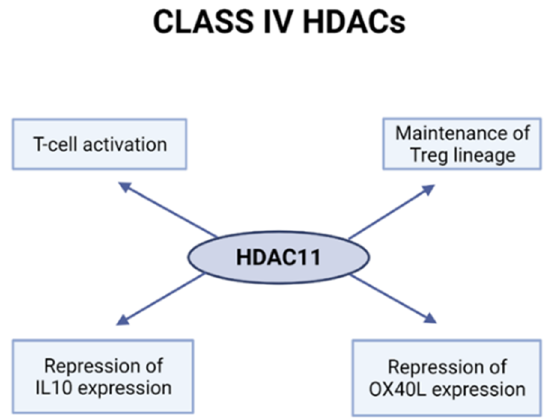
Figure 4. Role of class IV HDACs in T-cells. Created with BioRender. HDAC11 was also shown to be involved in the functioning of Treg cells through the regulation of Foxp3 [119]. Foxp3 plays a crucial role in Treg development and functions by regulating the expression of genes that determine the phenotype and suppressive ac- tivity of Tregs. Not only does HDAC11 regulate Foxp3 expression, but it can also bind to Foxp3 and promote its deacetylation. Deletion of HDAC11 in Foxp3+ Tregs enhanced Foxp3 expression and promoted the expression of other genes important to the develop- ment and maintenance of the Treg lineage and their suppressive role. Interestingly, the deletion as well as the pharmacological inhibition of HDAC11 promoted Treg-dependent long-term allograft acceptance. Furthermore, silencing of HDAC11 in Hodgkin lym- phoma cells induced expressions of OX40 ligand and pro-inflammatory cytokines, includ- ing TNF-α and IL-17, which could generate a favorable anti-tumor response with more effector and fewer regulatory T-cells [120]. 3. The Action of HDAC Inhibitors in the Maturation and Activation of T-Cells HDAC inhibitors (HDACi) are compounds that not only block the histone deacety- lase activity of HDAC proteins but also affect the interactions of HDACs with other com- ponents of multiprotein complexes and the acetylation status and stability of HDAC pro- teins themselves [121]. As HDACs are important players in T-cells, the effect of HDAC inhibition on T-cell biology is strong, including the activation and functions of both con- ventional and regulatory T-cells. The strongest effect of HDACi was described on tumor cells, and they have been used as drugs in T-cell malignancies. However, nontumor im- mune cells are also affected and the anti-inflammatory effect of HDACi was described, especially through the modulation of T-cell activation and enhancement of Treg suppres- sive function [121]. HDACi were shown to affect Treg, APC, and T-cell interactions. In Tregs, HDACi increase the FOXP3 acetylation and stability as well as its function as a transcription factor that promotes genes associated with Treg function and their suppressive activity [92]. In the presence of HDACi, there is a decrease in proinflammatory cytokine release in APC cells which influences their T-cell stimulatory function [122]. In T-cells, HDACi affect the T-cell development, the maintenance of the naïve T-cell compartment, T-cell activation pathways, and T-cell immune responses [121]. HDACi promote the early activation of CD4+ cells by enhancing the production of Th1 and Th2 lineage cytokines and promoting cytokine release. They affect the proliferation of activated naïve T-cells by inhibiting the production of IL-2 and down-regulation of CD25 and CD154 [123]. In the early differenti- ation and polarization of Th0 cells, HDACi can influence cytokine gene transcription and